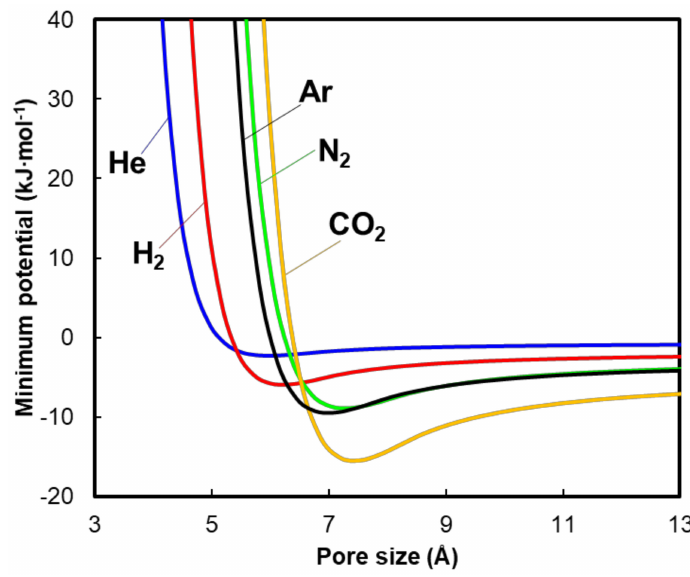
Figure 4. The minimum potential with respect to pore size, for different